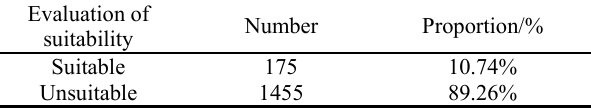
Table 4. Number and proportion of grid in suitable area.